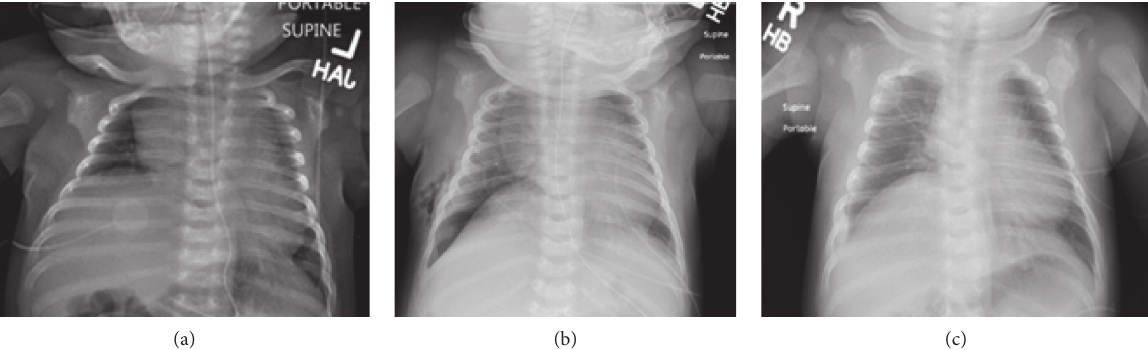
Figure 1: (a) Chest radiograph prior to surgery showing elevation of right hemidiaphragm. (b) Chest radiograph immediately after surgery demonstrating expansion of the right lung field with small basilar pneumothorax and minimal subcutaneous emphysema. (c) Chest radiograph one-month postoperatively demonstrating continued increased right hemithorax volumes with excellent lung expansion.